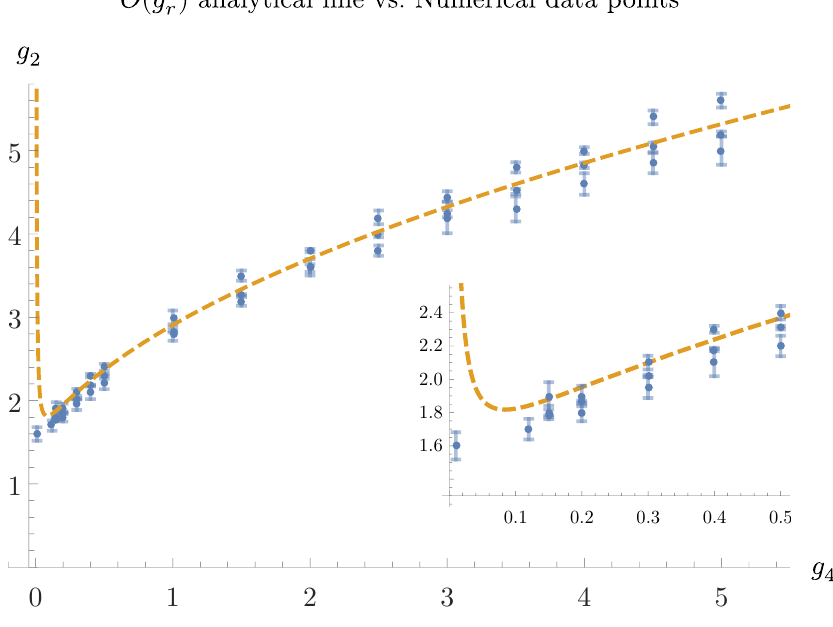
) transition line (4.10) vs. N = 24 numerical data points. All the data Figure 5 . Analytical O ( g 4 r points from C , χ and ρ (0) are now the same